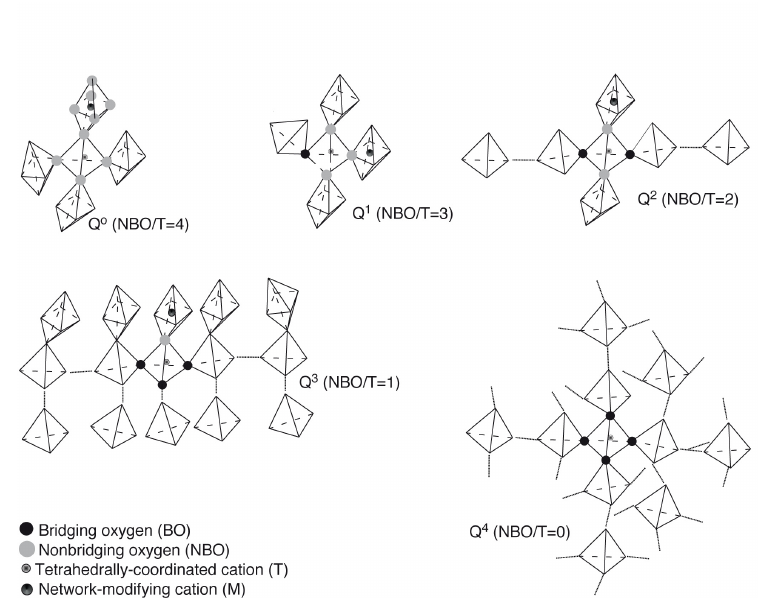
Figure 5: Schematic representation of interconnected silicate tetrahedra and larger metal oxide polyhedra in the various Q" structural units [3]. In the Q 4 sketch, the short lines indicate effectively infinite extension of the structure. The ratio of nonbridging oxygens over tetrahedrally cations (NBO/T) is a simple measure of the degree of polymerization of the silicate